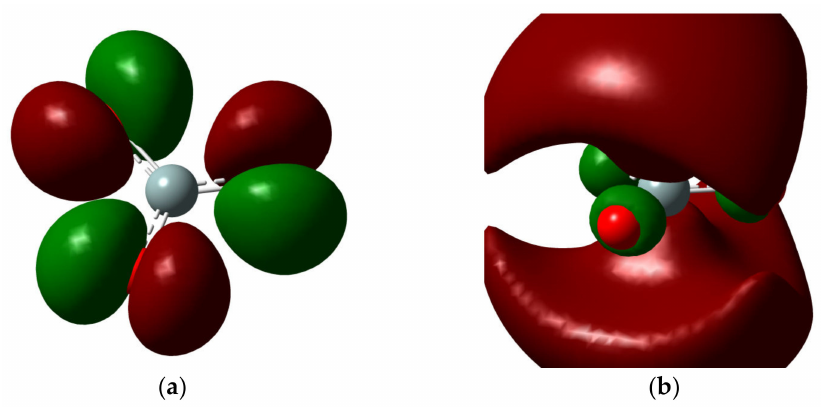
Figure 2. Quantum calculations for SiO 3 molecule. ( a ) HOMO state and ( b ) LUMO state.